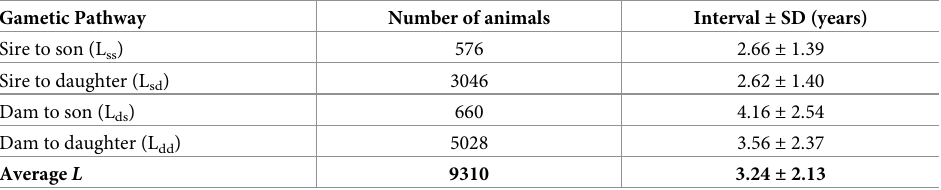
Table 2. Number of animals, generation interval and standard deviation (SD) for the four gametic pathways of the German White-headed Mutton sheep